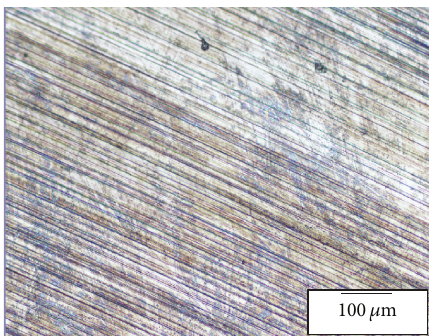
Figure 15: Optical microscopy of the machined surface under spindle speed = 1250 rpm, depth of cut = 0.5 mm, and table feed rate = 125